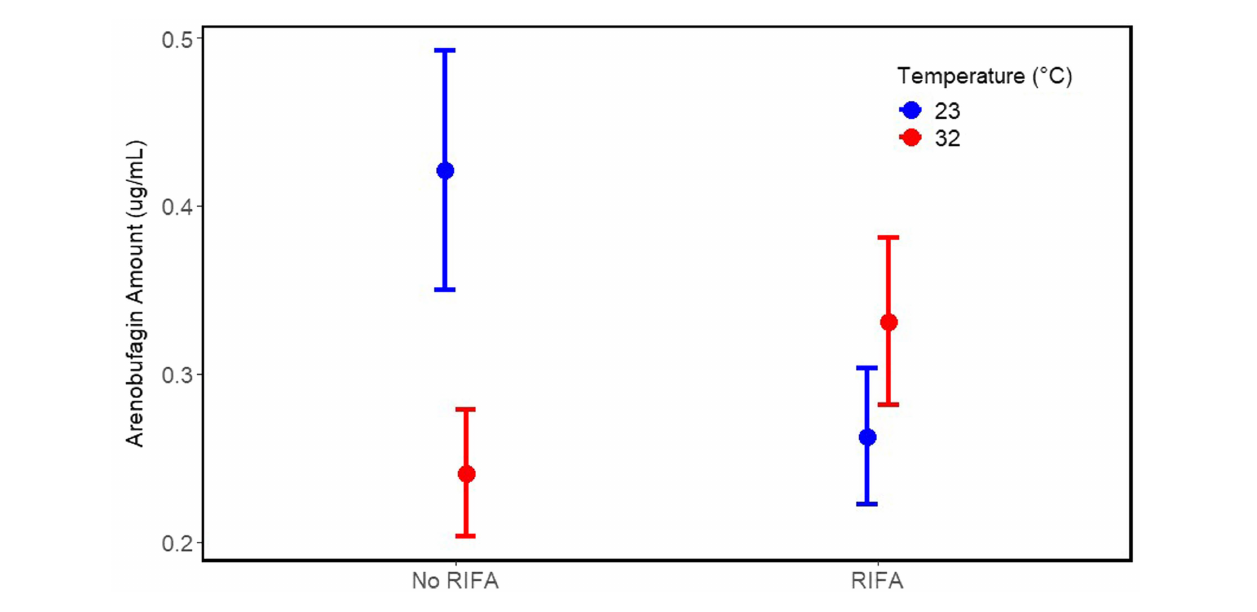
FIGURE 4 Estimated marginal means of the concentration of Arenobufagin in I. nebulifer toadlets in response to RIFA exposure and water temperature. Error bars are 95% confidence